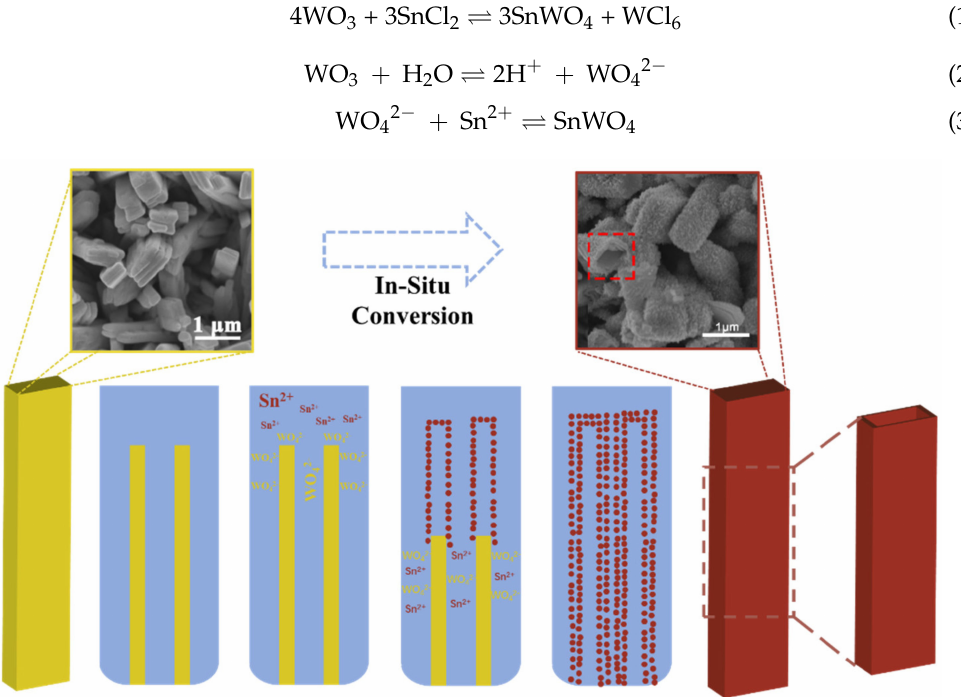
Figure 3. Schematic for in situ conversion from a rod-like WO 3 array to a rod-like SnWO 4